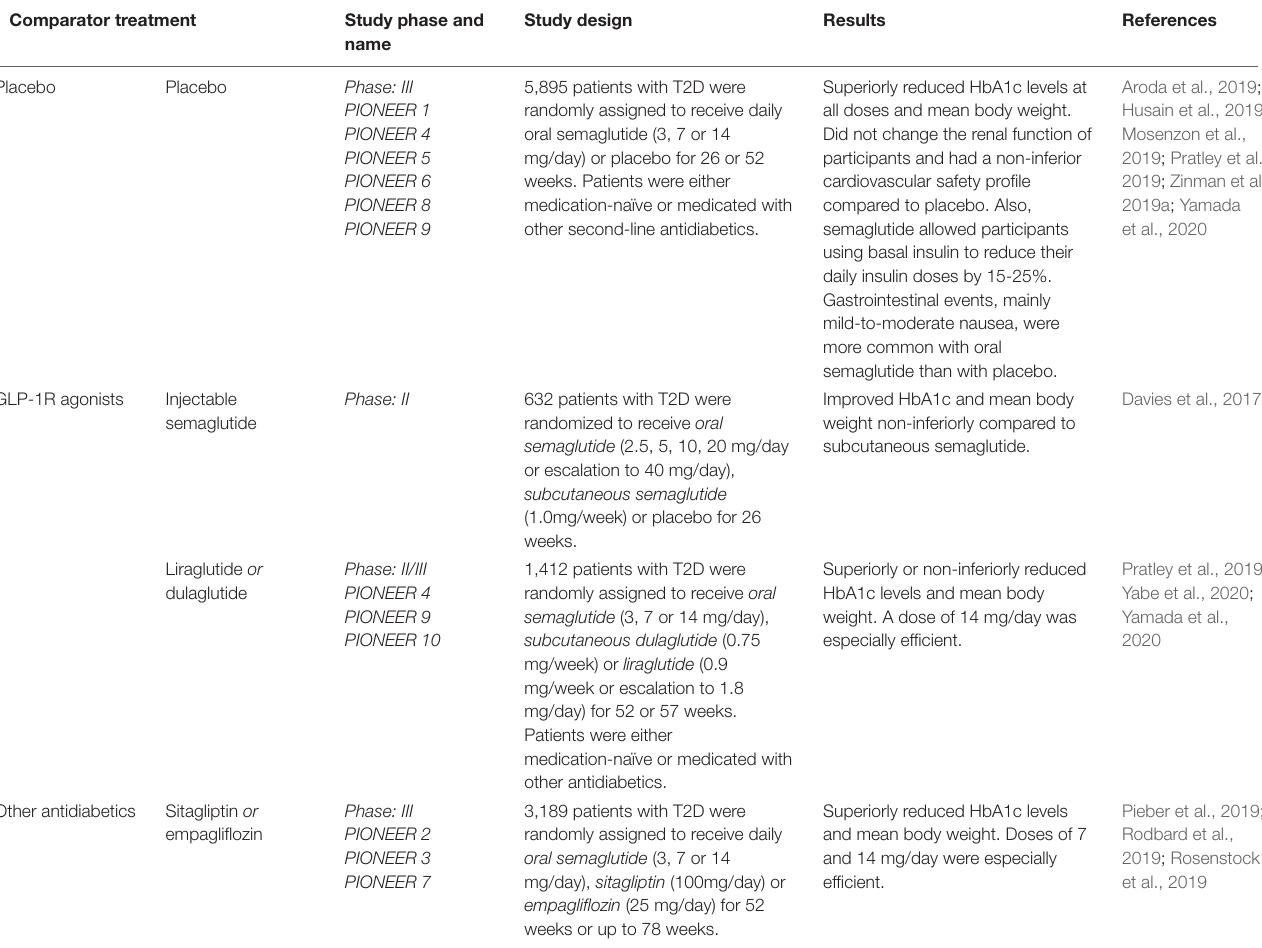
TABLE 2 | Clinical interventional studies elucidating the efficacy and safety-profile of oral semaglutide in comparison to placebo or other antidiabetics in patients with